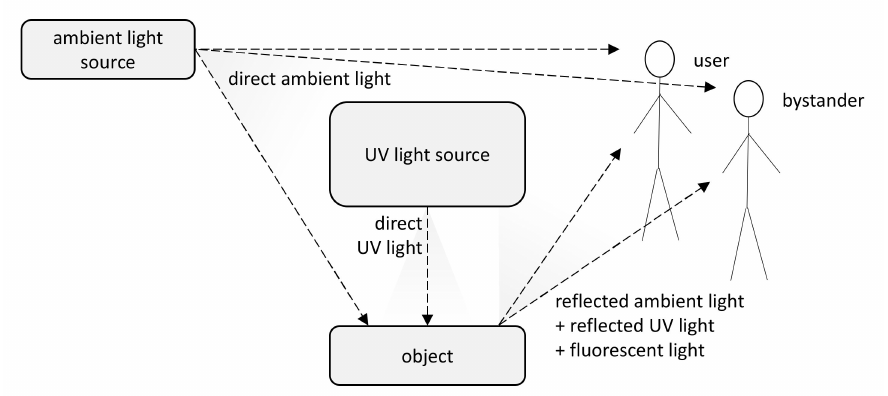
Figure 1. A typical approach to detection of fluorescent markers—fluorescent light induced by UV light is masked by ambient light, with the results visible to other people (adapted from [3]).